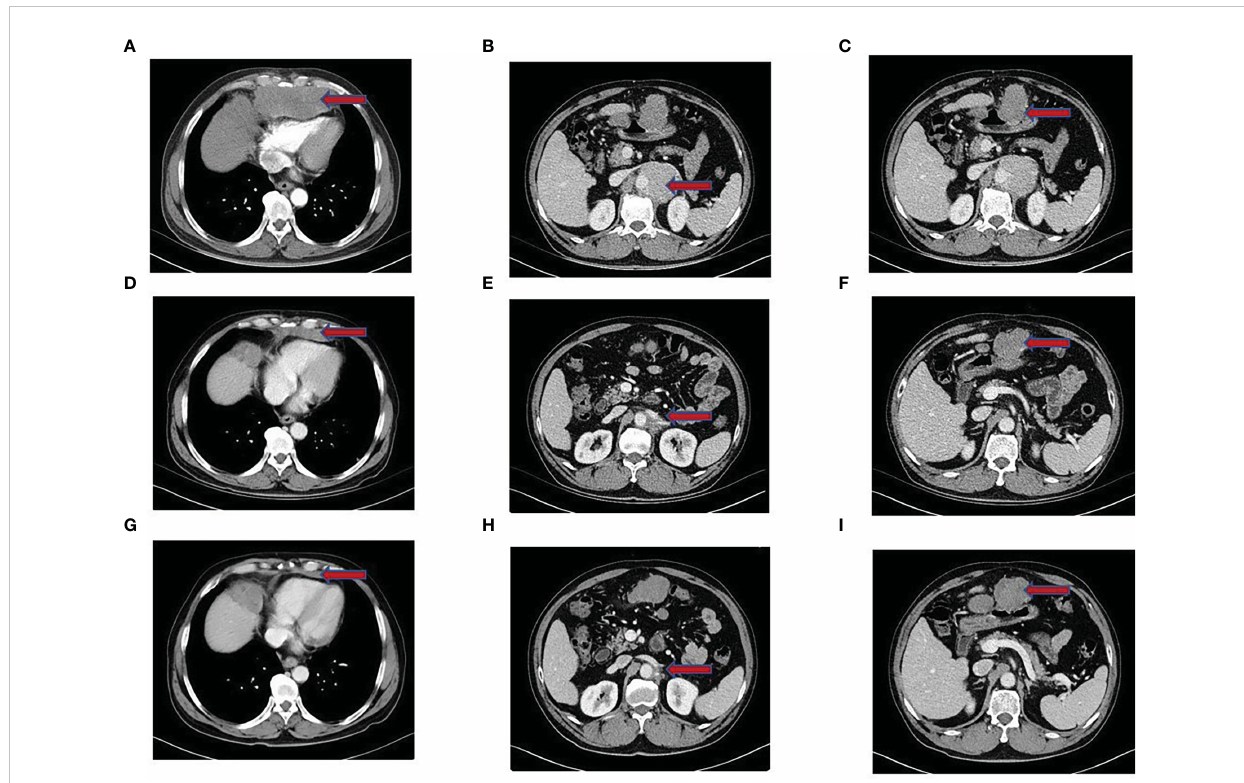
FIGURE 1 Imaging performance. (A – C) Enhanced CT of the chest and abdomen before treatment showed a dense mass shadow of soft tissue in the anterior mediastinum, multiple retroperitoneal lymph nodes enlarged and fused into a mass, and left liver occupancy. (D – F) After 2 months of tislelizumab combined with epirubicin treatment, the CT showed a signi fi cantly smaller lesion shadow than before, and the ef fi cacy evaluation was PR. (G – I) In April 2022, Chest CT showed that the size of the anterior mediastinal hypodense foci was similar to that before. CT of abdominopelvic cavity showed multiple posterior peritoneal and perihepatic occupations with increased lesion extent compared to previous CT, and some of the lesions were new. Suspicious new nodules in segment VI of the liver, and ef fi cacy evaluation of